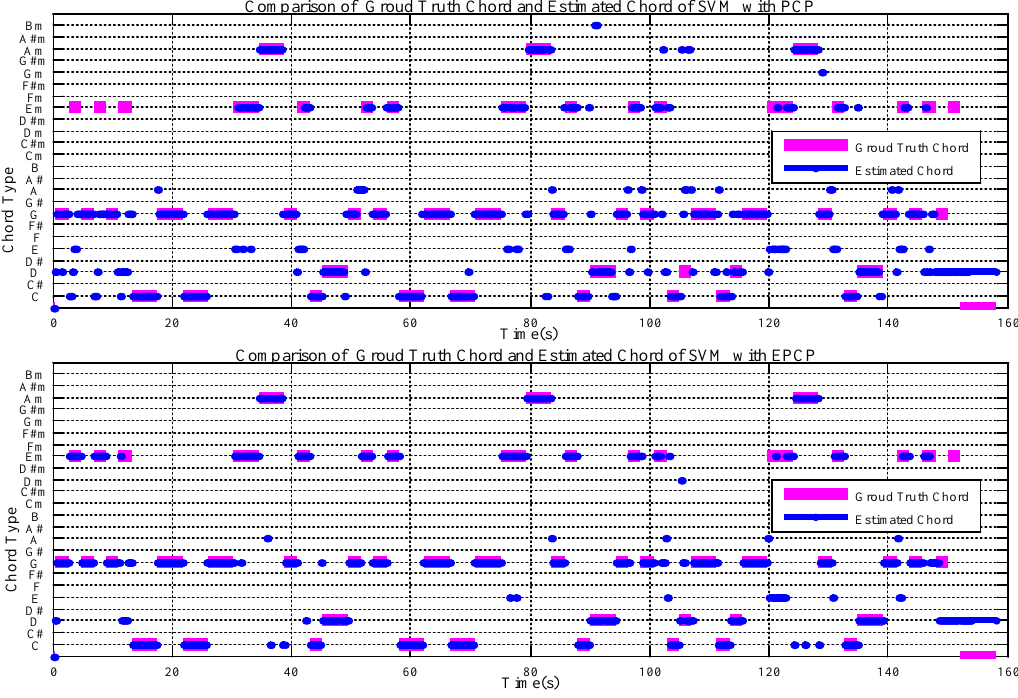
Figure 7. Comparison of ground truth and estimated chord with PCP ( top ) and EPCP ( bottom ). Appl. Sci. 2016 , 6 , 157